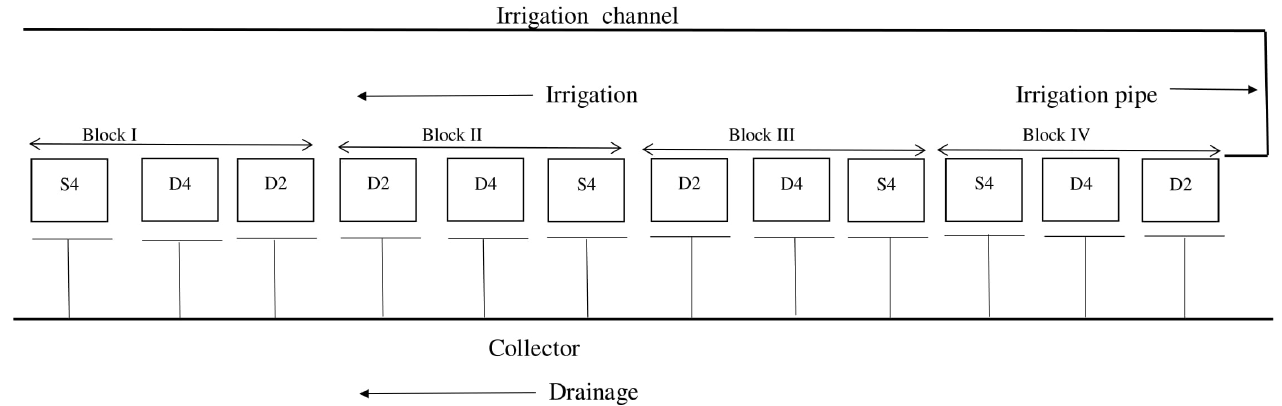
Figure 1. Experimental set-up of blocks (I–IV) and plots within blocks with three treatments: shallow drainage to 0.6 m depth, with weir open four times per week (S4), and deep drainage to 1.2 m depth, with weir open four times per week (D4) or two times per week (D2).